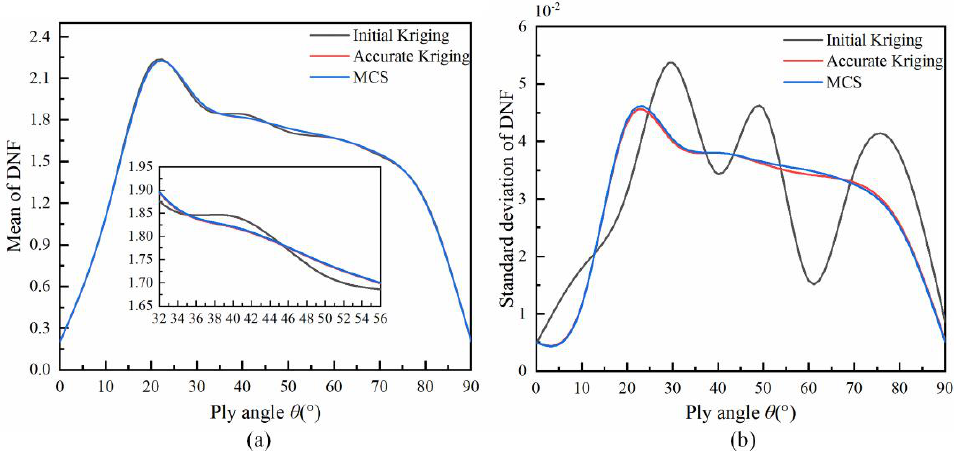
Figure 5. The mean and standard deviation of DNF for the five-layer laminated composite cylindrical shells with clamped – supported boundary conditions. ( a ) mean, ( b ) standard deviation.